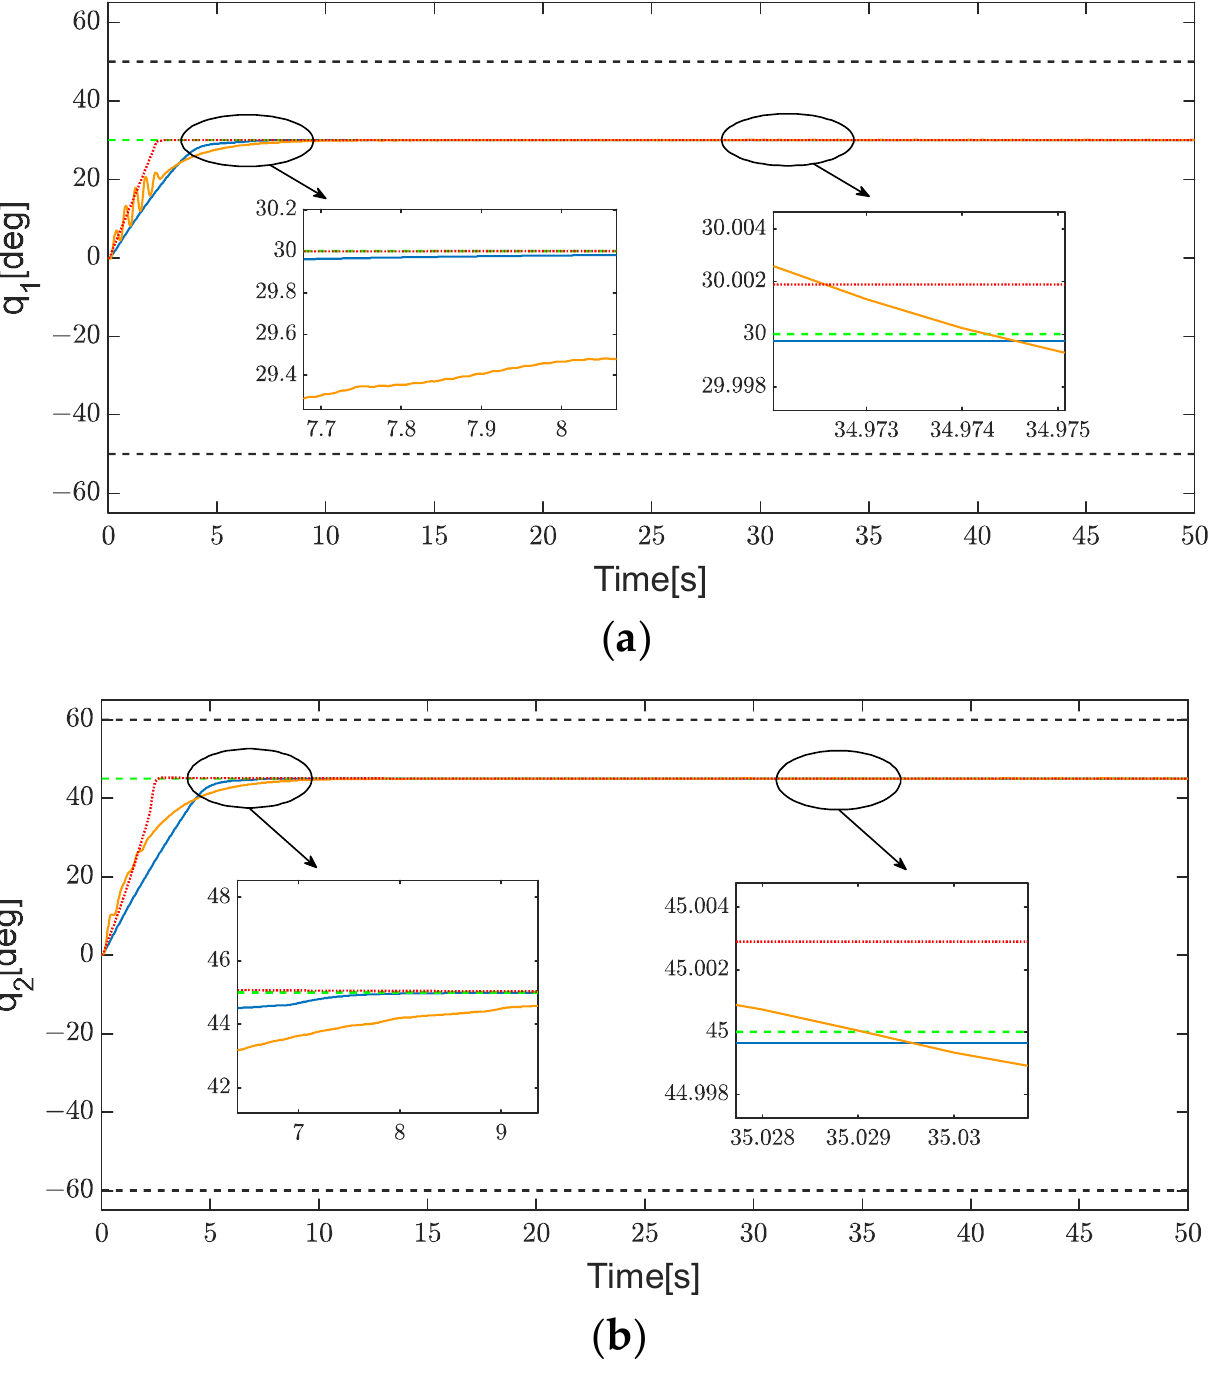
Figure 7. Comparison of the angular position to [43,44] in case 1: [43] scheme (yellow solid line), [44] scheme (red dash line), the proposed scheme (blue solid line), the reference angular position (green dashed line), the angular position constrains (black dashed line); ( a ) Joint 1. ( b ) Joint 2.